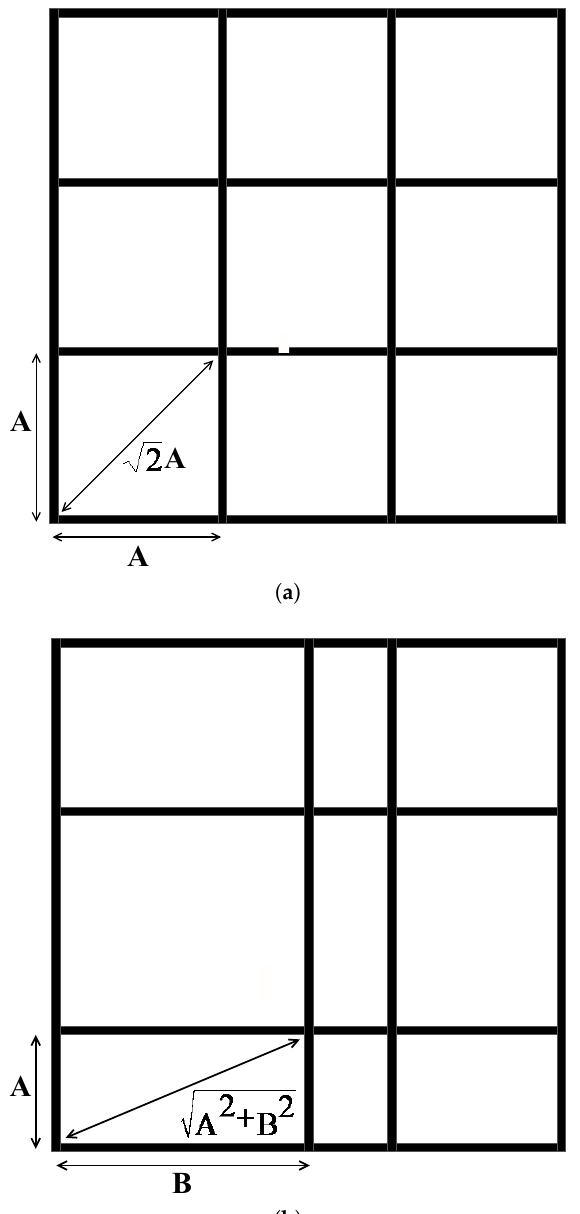
Figure 2. Based on substation equipment layout, grounding grid can be configured as equally spaced or unequally spaced. ( a ) Equally spaced grounding grid configuration have all the branches of equal length. ( b ) Unequally spaced grounding grid have branches of unequal